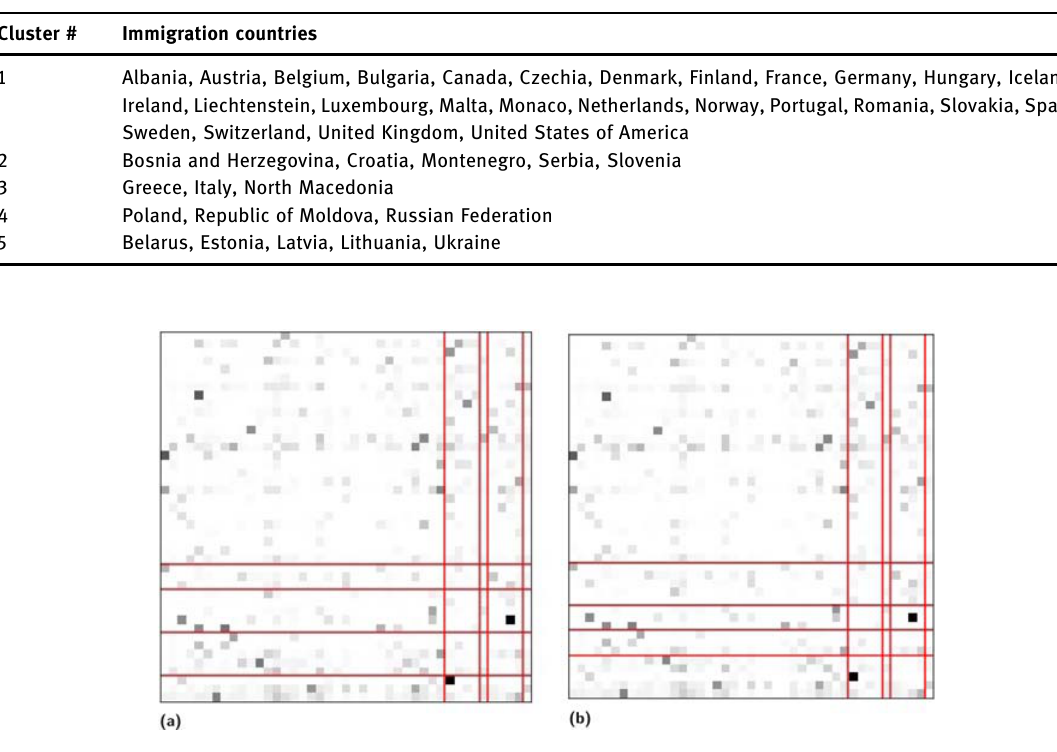
Figure 3: Immigration – emigration cluster - pairs with the countries rearranged by their cluster memberships. The frequency counts are represented with light to dark squares. ( a ) 2015 and ( b )